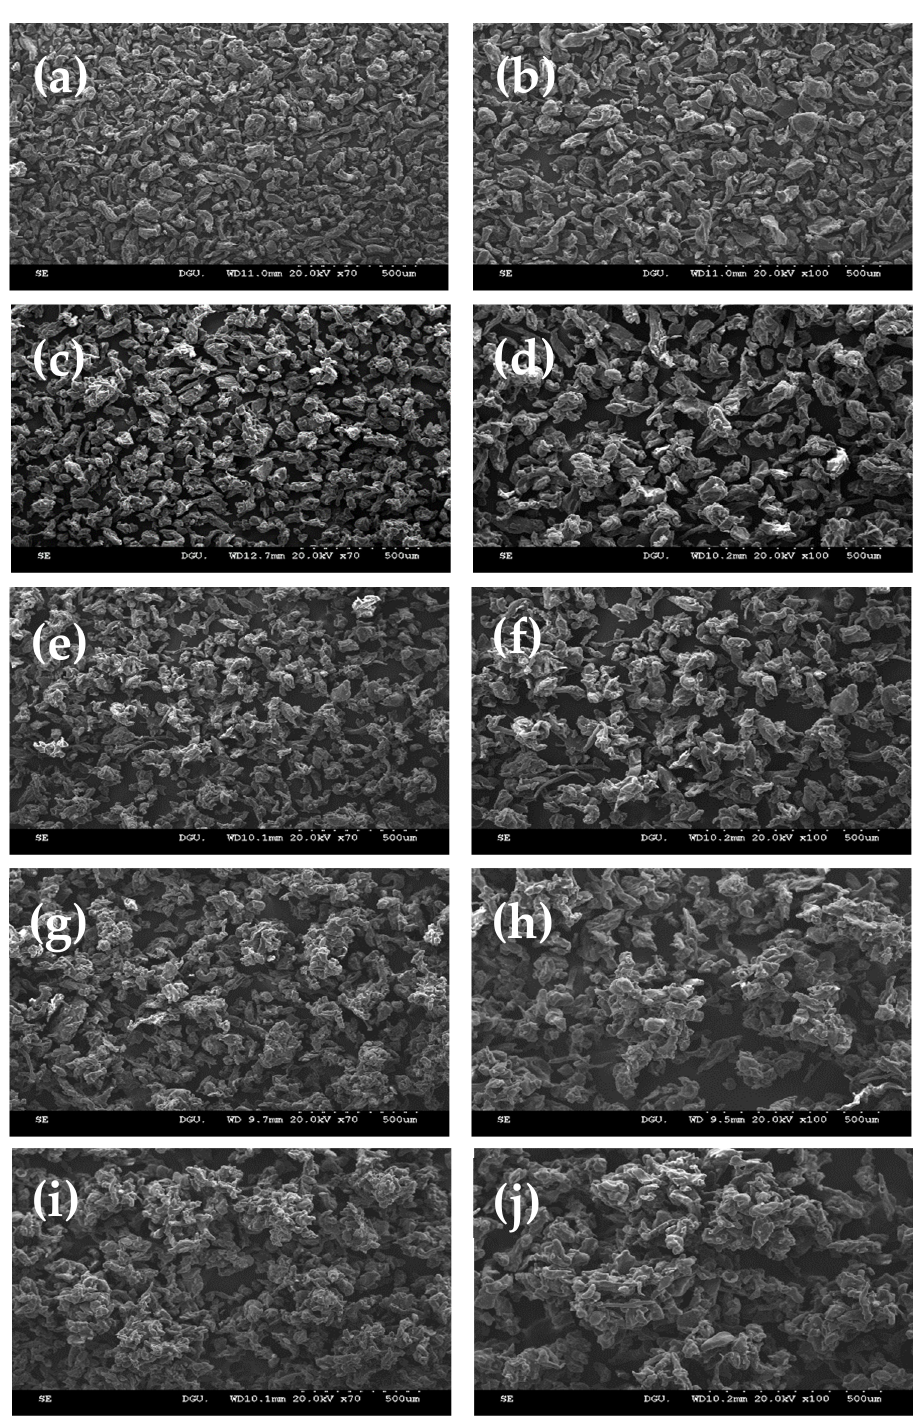
Figure 1. Respective low-magnification (70×) and high-magnification (100×) SEM micrographs of ( a , b ) non-agglomerated and agglomerated guar gum (GG) powders with various concentrations of sucrose binder: ( c , d ) GG–0%, ( e , f ) GG–10%, ( g , h ) GG–20%, ( i , j ) GG–30%.